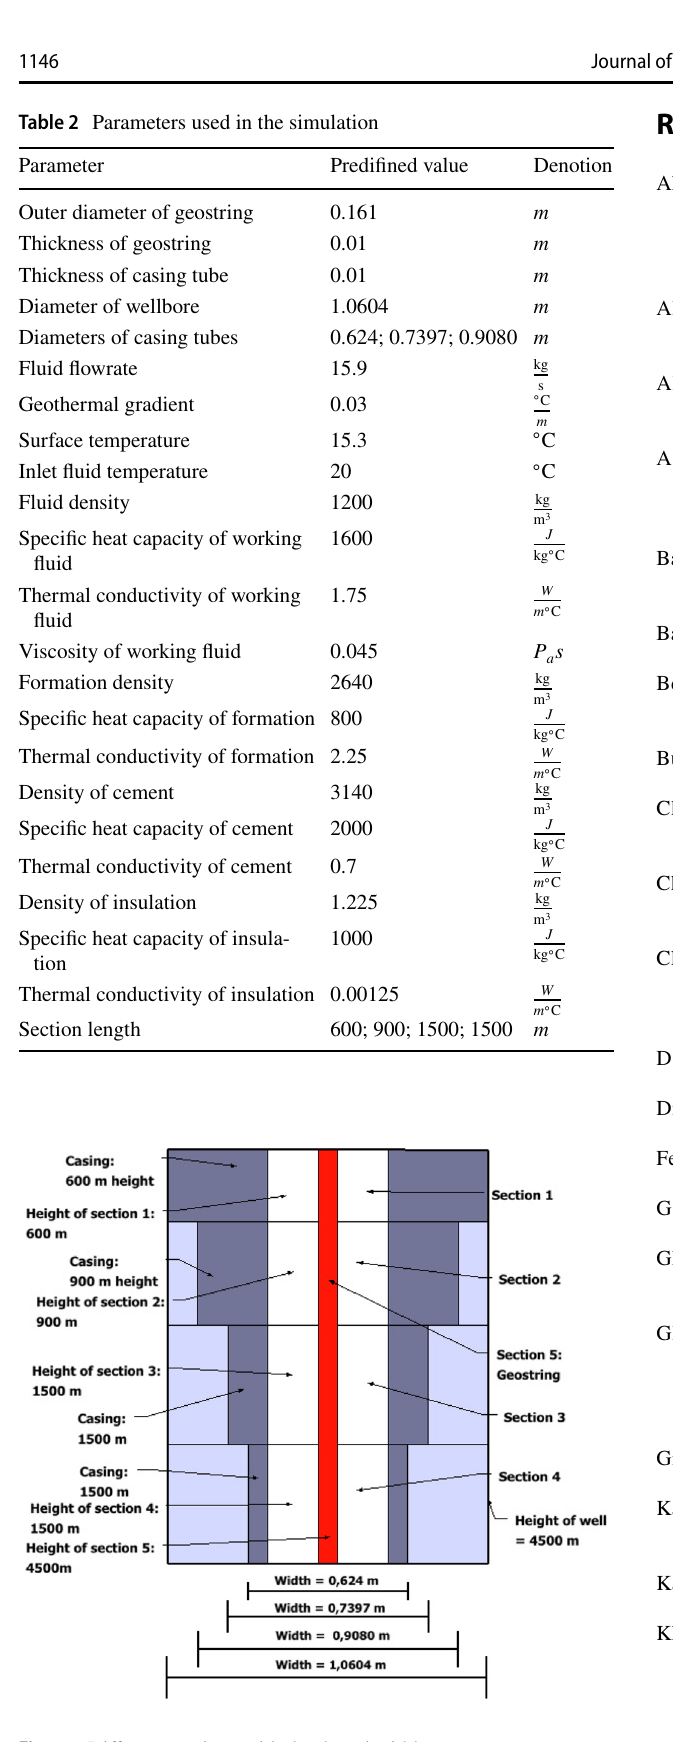
Fig. 10 Different sections with depth and